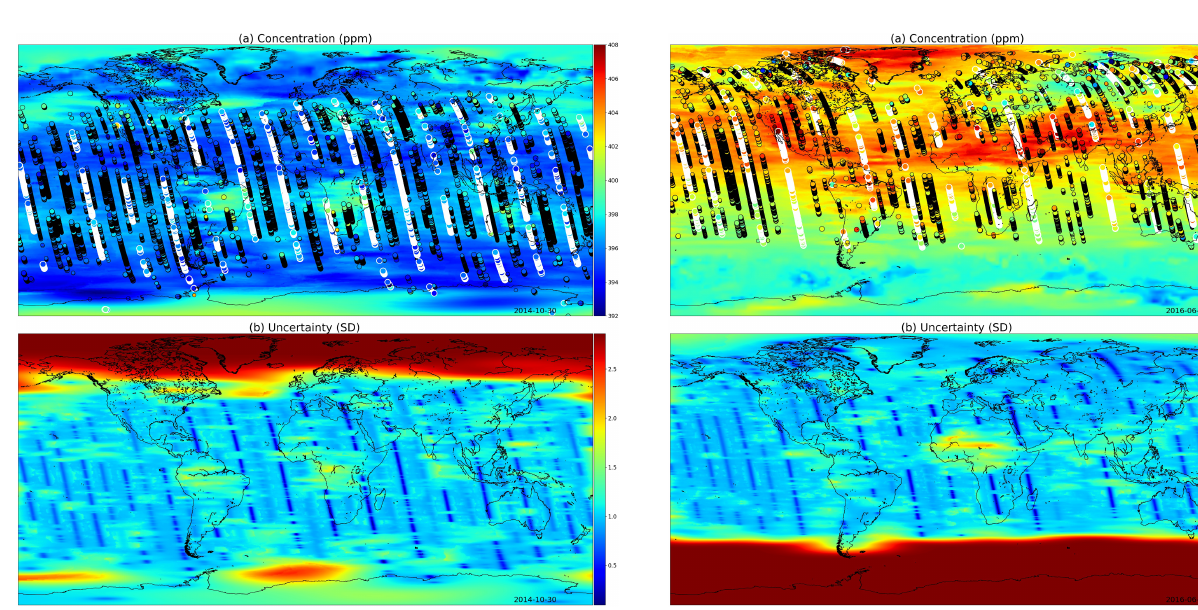
Figure 9. (a) XCO 2 posterior mean values and (b) their uncertain- ties on the 30 October 2014. The most informative observations are shown with the concentrations, with the large white circles being from the 30th, medium circles from 1d before or after, and small circles from 2days before or after. The OCO-2 utilizes sunlight for retrieval, which is why there are very few observations above 60 ◦ N. These fields include latitudes up to 85 ◦ S and 85 ◦ N.